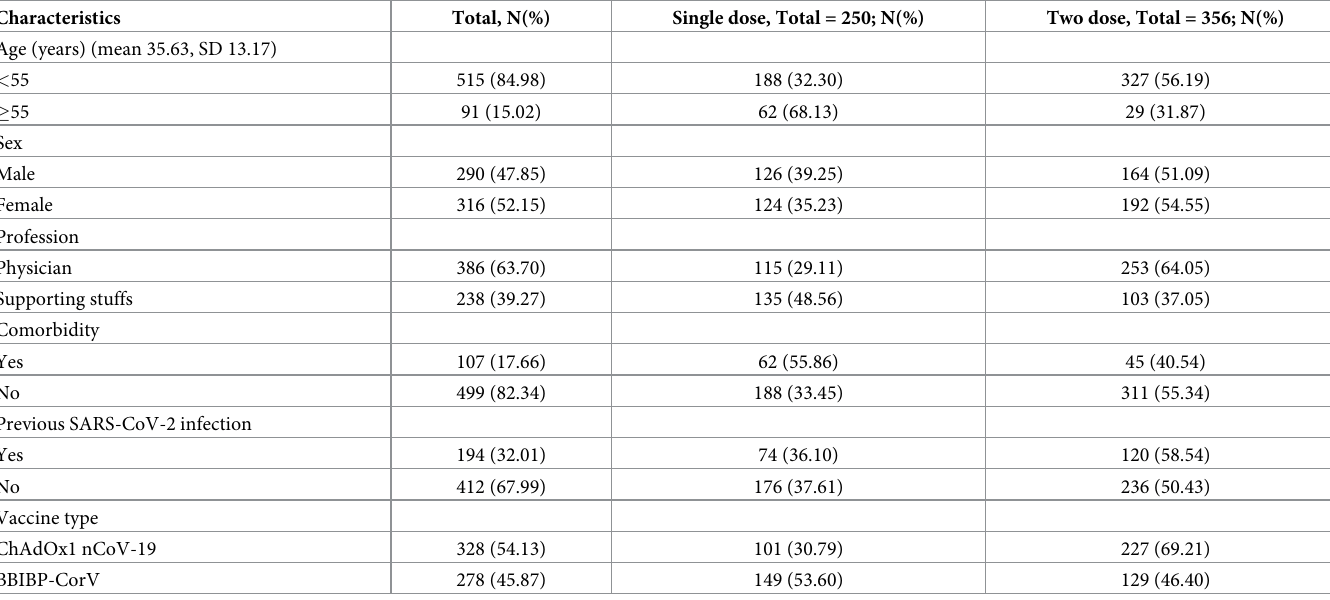
Table 1. Socio-demographic characteristics of the participants (n = 606).